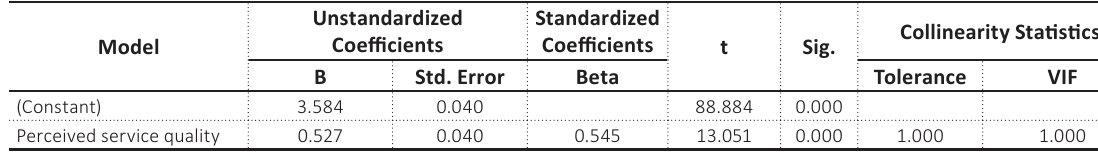
Table 5. Regression results (perceived service quality and customers’ repurchase